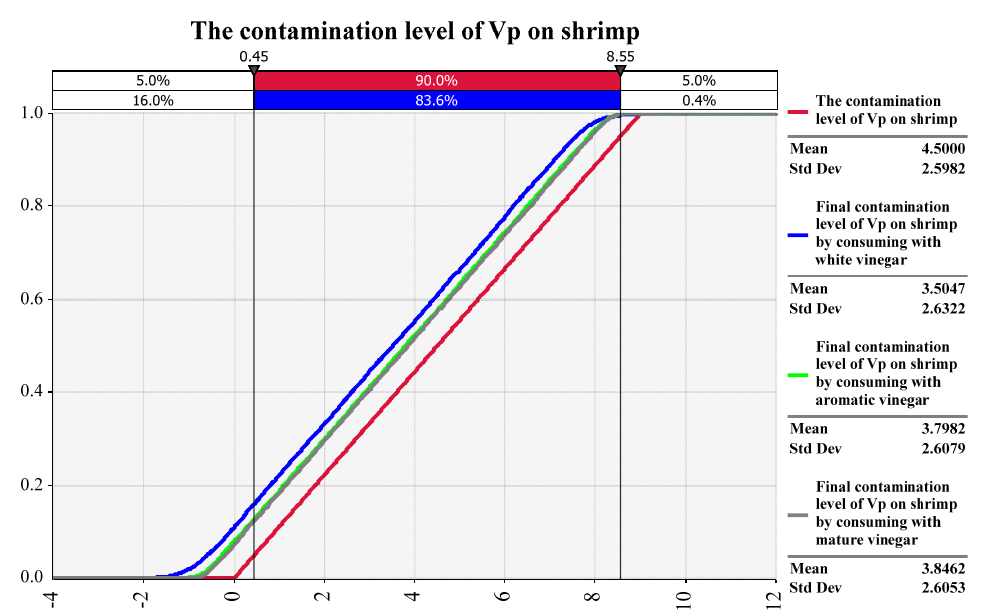
Figure 3. The final contamination level of V. parahaemolyticus on ready − to − eat shrimp by consuming without anything (Red Line), and with white vinegar (Blue Line), aromatic vinegar (Green Line) and mature vinegar (Grey Line). Note: Vp = Vibrio parahaemolyticus .